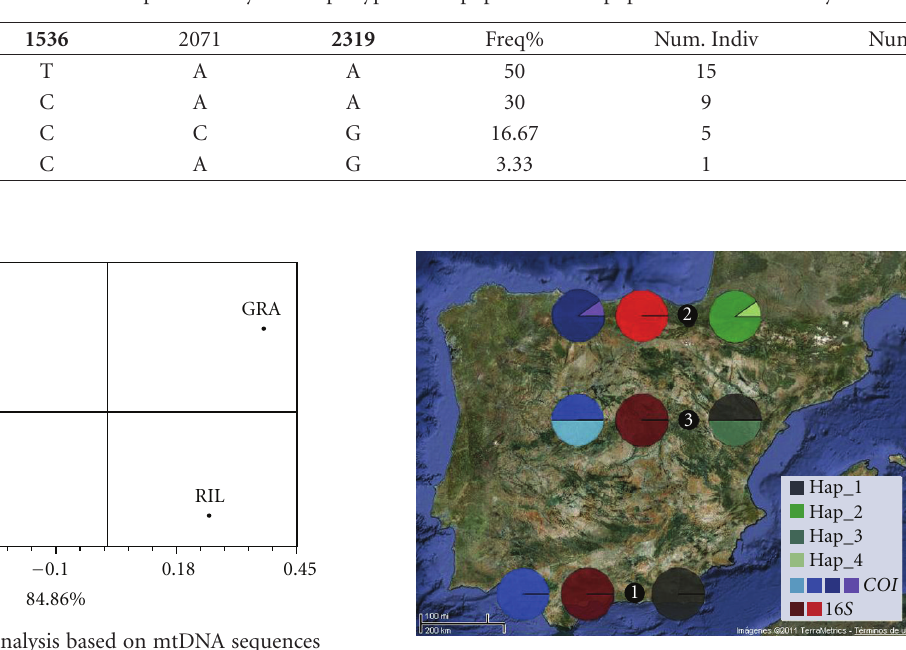
Figure 2: Geographic localization and genetic composition of 30 individuals from 3 di ff erent populations. Each population is shown as 3 pie charts representing membership proportions. In blue series: COI mtDNA gene, red series: 16S mtDNA gene and green series as total